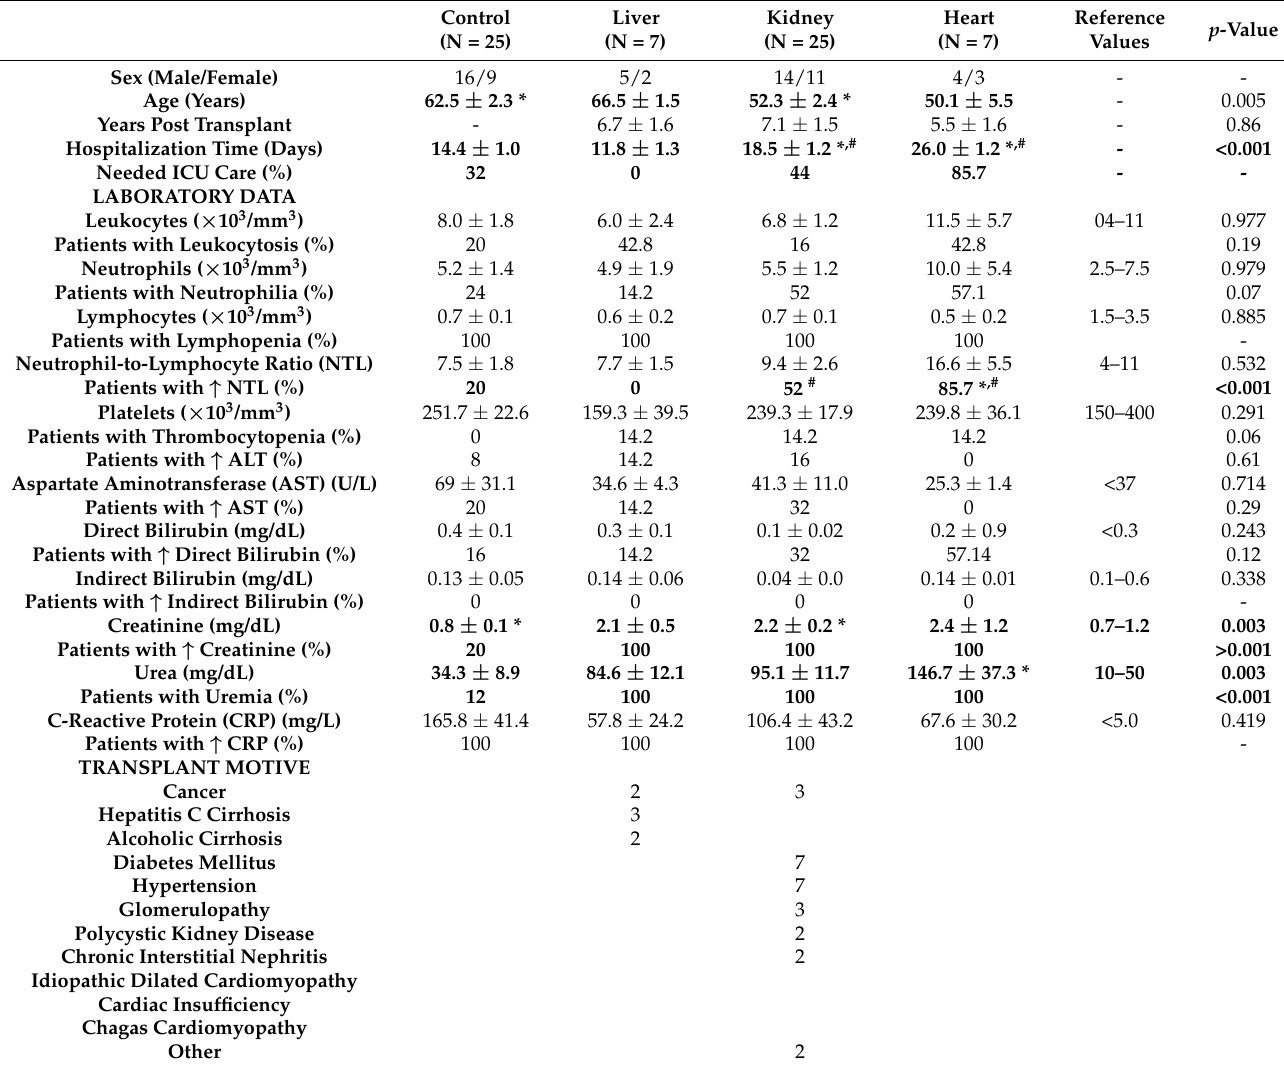
Table 1. Patients’ characteristics on